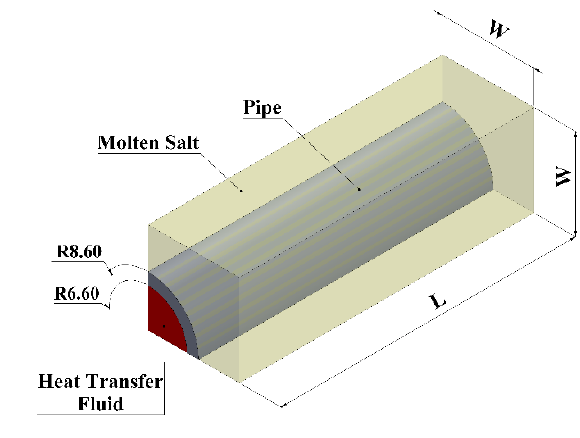
Figure 1. Simplified 3-D Model.